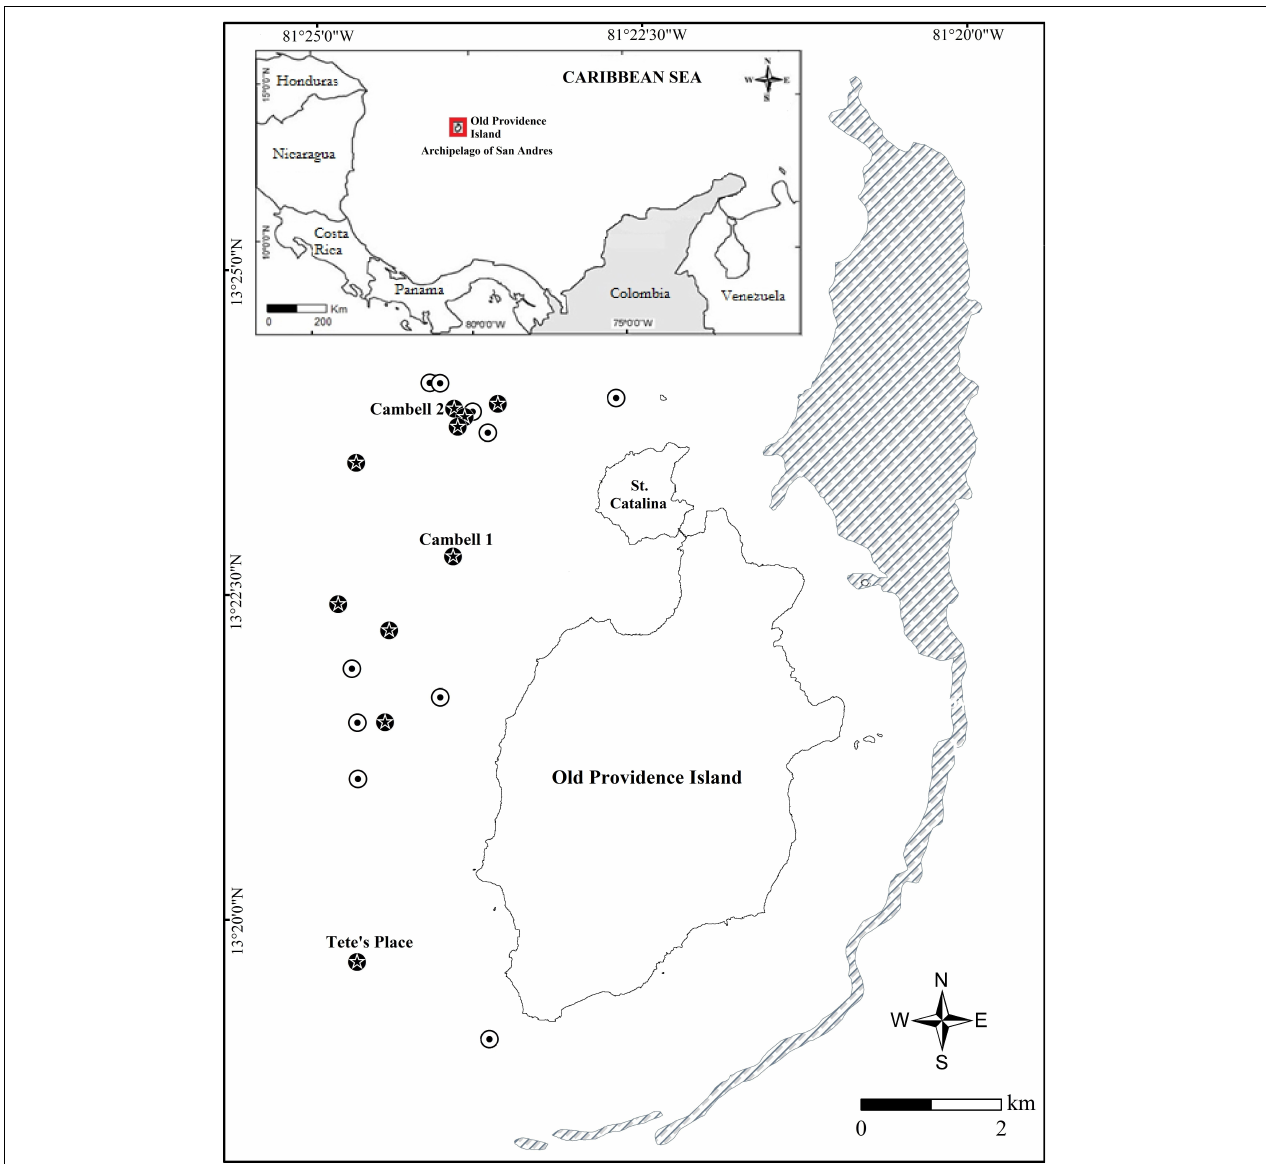
FIGURE 1 | Study area in Old Providence and St. Catalina Islands. Black circles with stars: plots where colonies were found in 2002 and 2012. White circles with dots: plots where colonies were found in 2002, but not in 2012. Barrier reef: striped area east of the islands. Cambell 1, Cambell 2, and Tete’s Place are popular dive